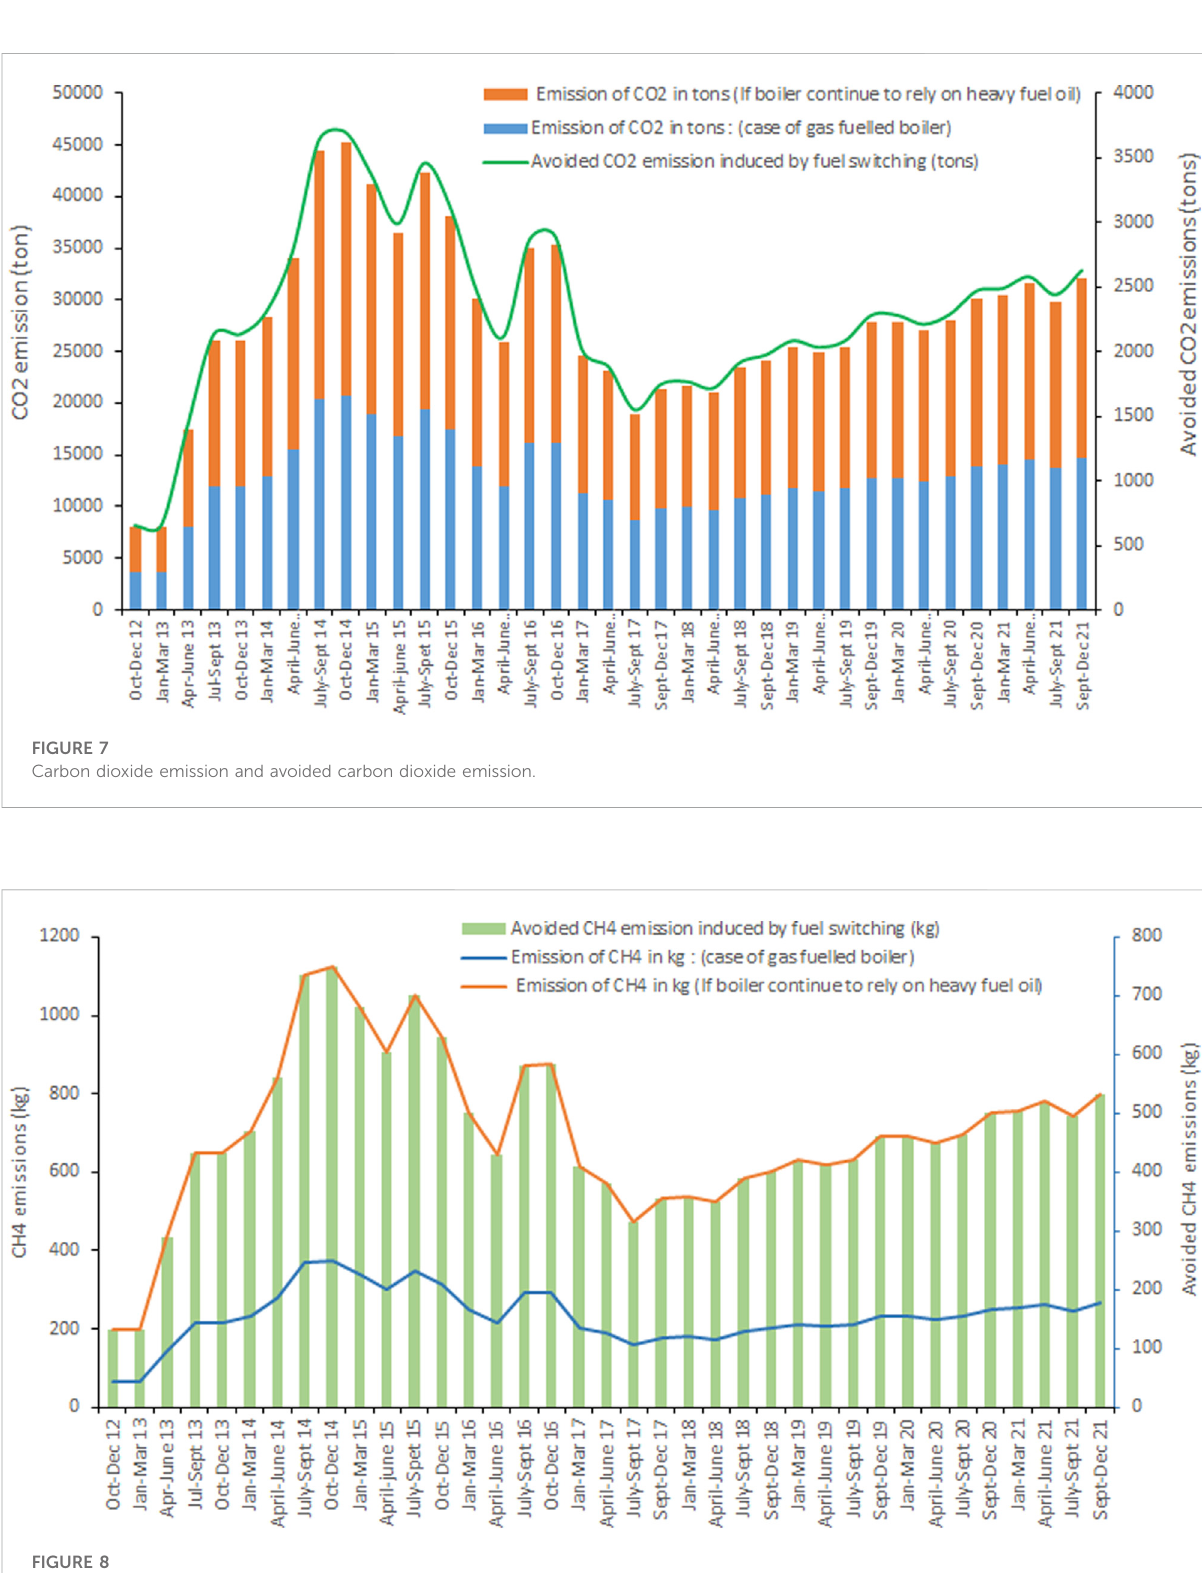
FIGURE 8 Methane emission and avoided methane